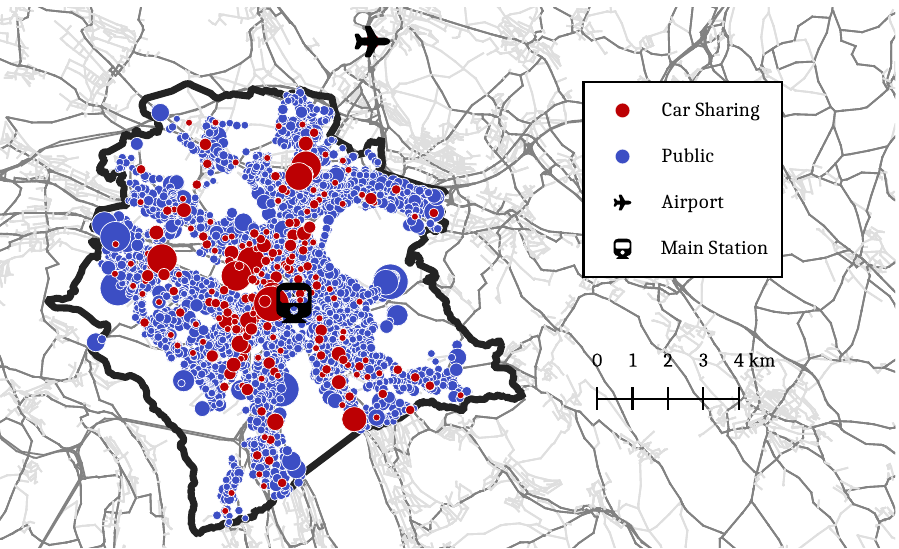
Figure 1. Distribution of parking spots. All blue dots represent public parking spaces in Zurich city. Red dots represent the parking locations of the car-sharing service Mobility in 2015. Their size qualitatively represents the number of parking spots at the respective roads. A possible depot location is placed at either the airport or main train station in the center of the